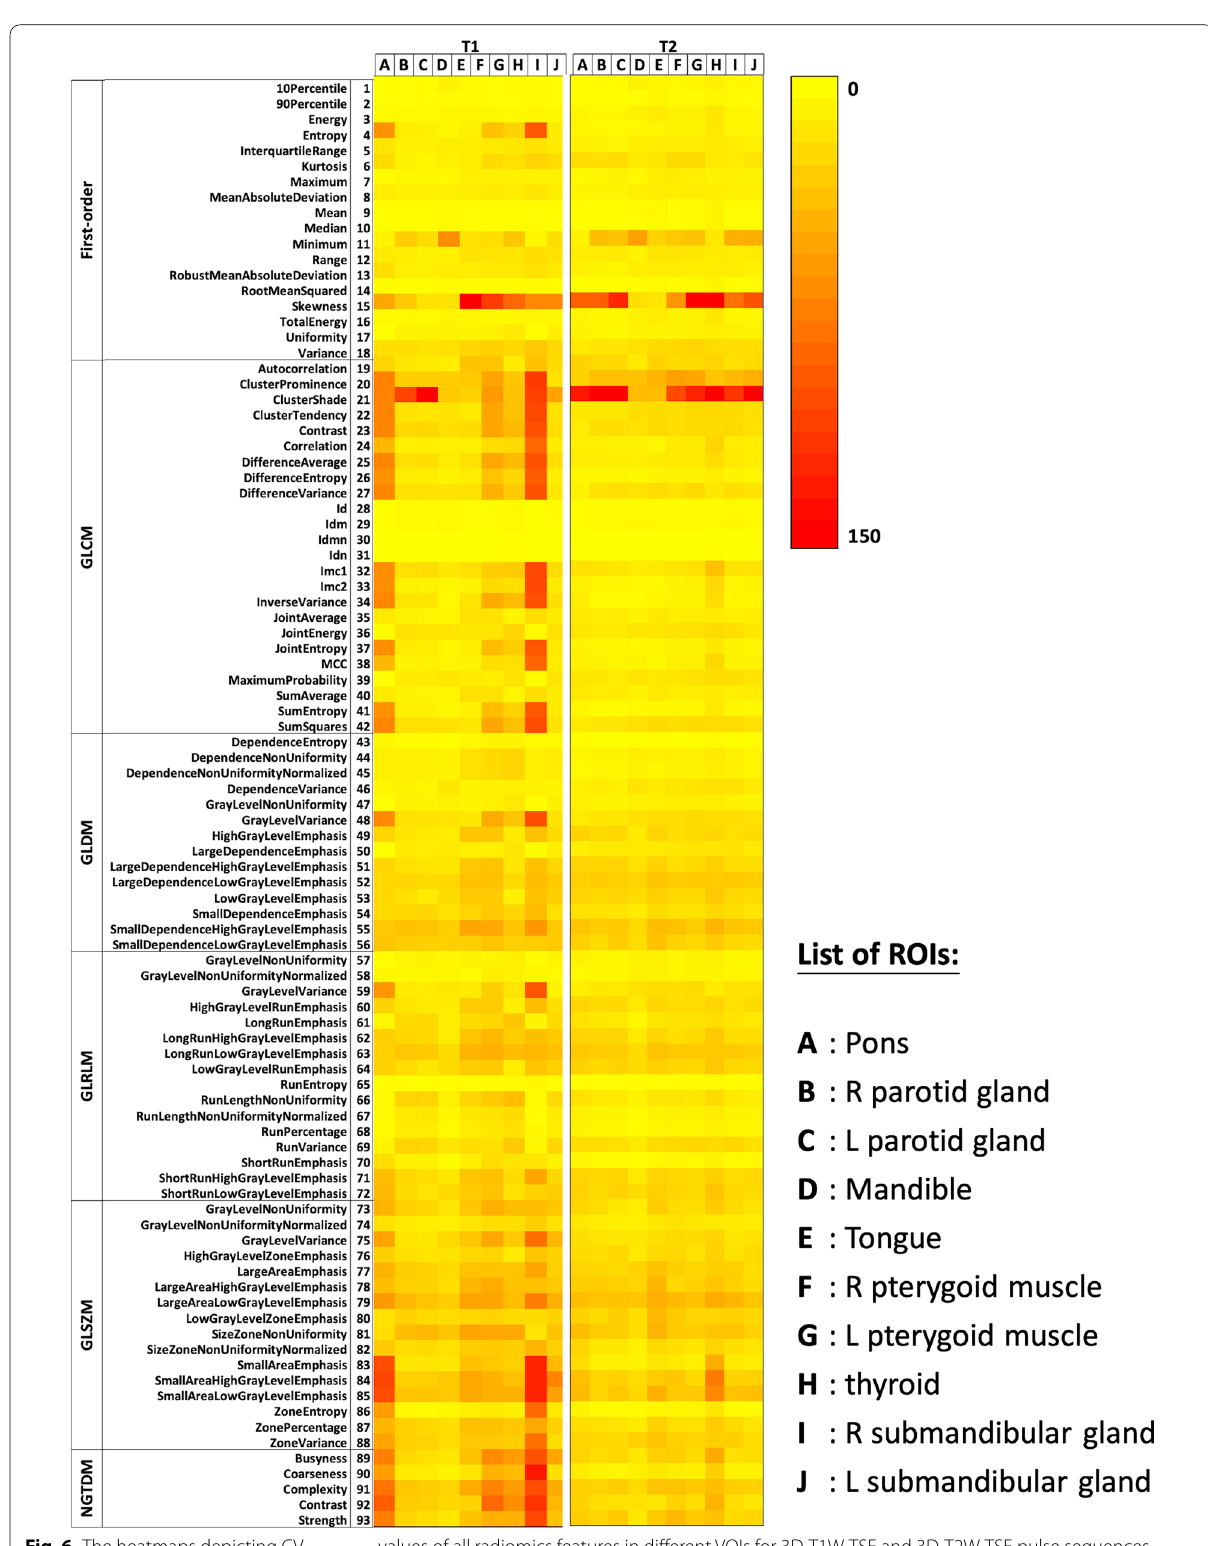
Fig. 6 The heatmaps depicting CV intra-subject values of all radiomics features in different VOIs for 3D-T1W-TSE and 3D-T2W-TSE pulse